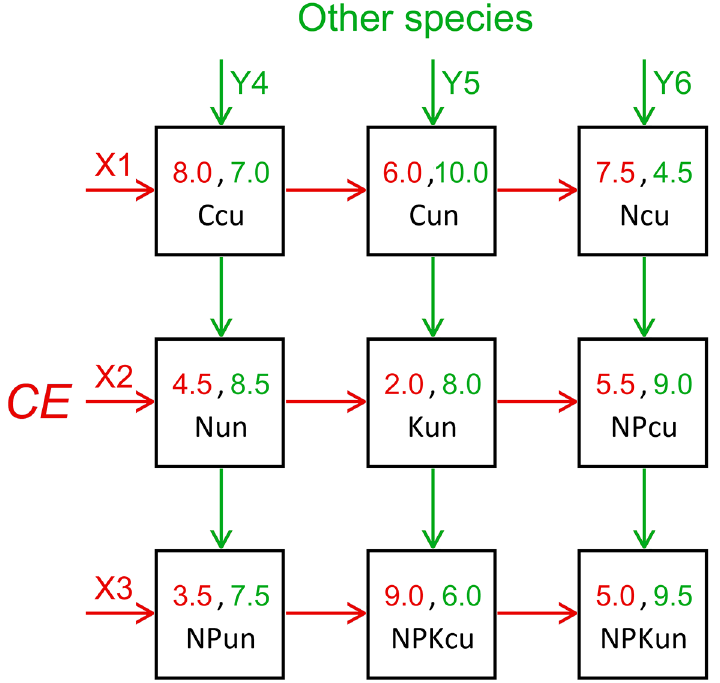
Fig 1. The derived payoff bimatrix: One of the 10,080 permutations. The bimatrix includes abundance values of the bushgrass Calamagrostis epigejos (CE) in multiples of 10% and numbers of the other species that were found (individual abundances of the other species have not taken into